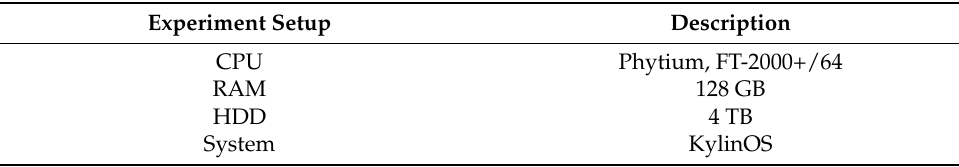
Table 1. Experiment set up of hardware and